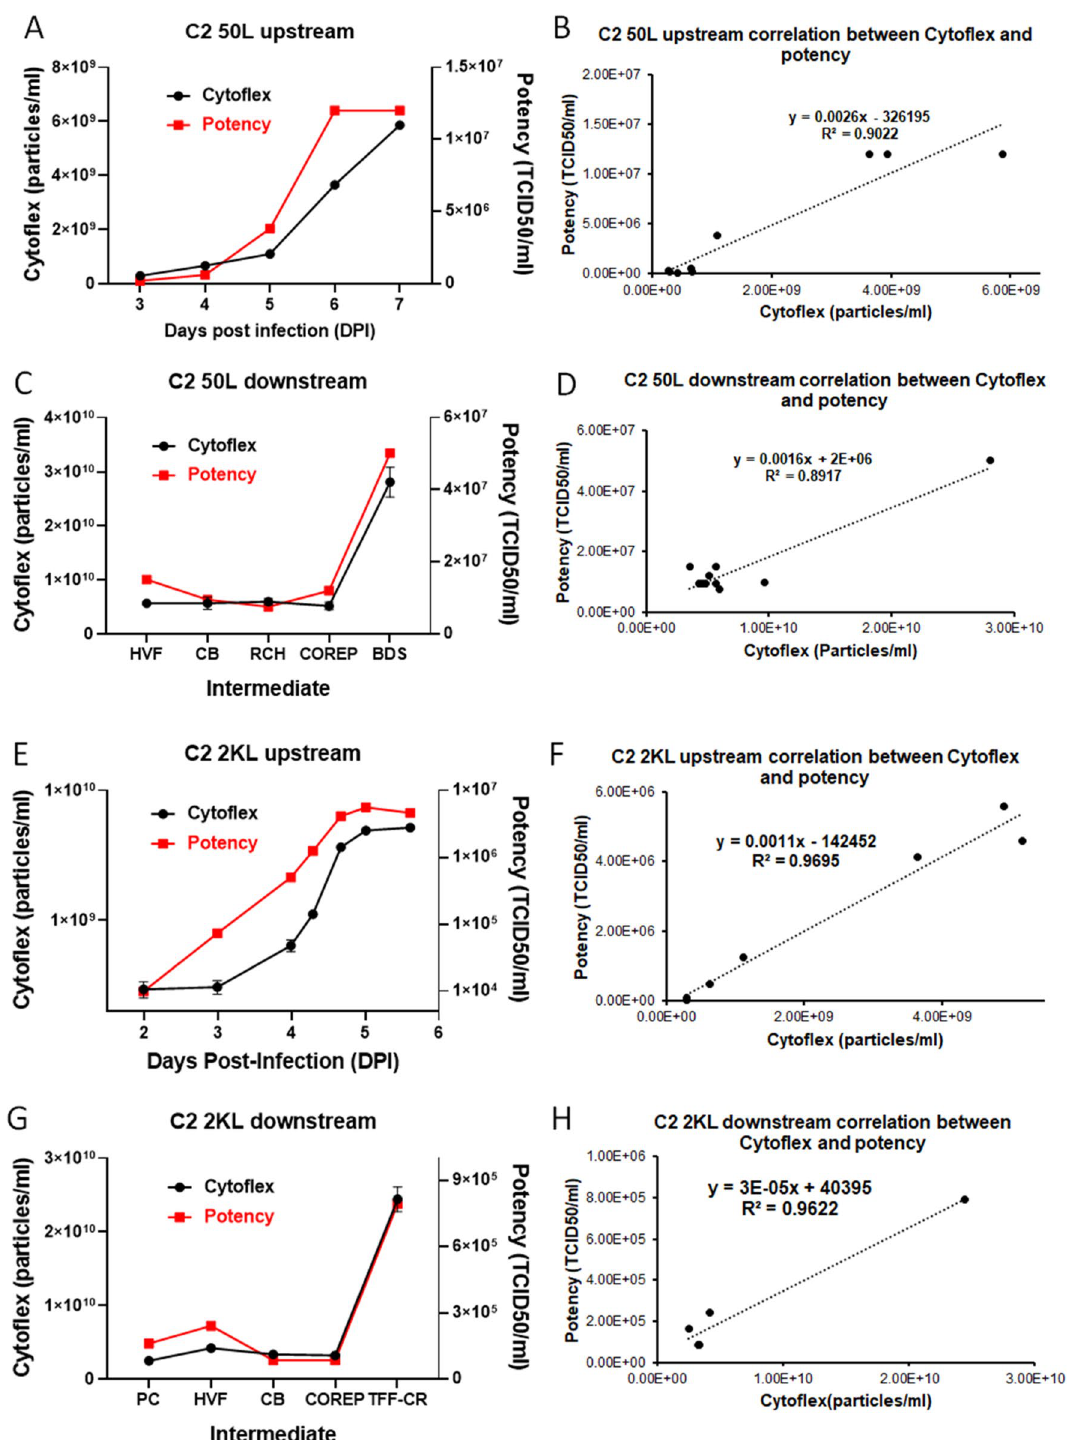
Figure 7. The production of C2 manufactured in 50L and 2000L bioreactors was monitored by CytoFLEX and showed strong correlation with potency. ( A ) Potency and total particle count of C2 50L bioreactor samples at different days post infection (DPI). ( B ) Correlation between total particle count measured by CytoFLEX and potency obtained from TCID50 assay for C2 50L bioreactor samples (R = 0.95, N = 9). ( C ) Potency and total particle count of C2 50L after each downstream process step for virus harvest, clarification, endonuclease reaction, purification, and concentration: production culture (PC), harvested viral fluid (HVF), clarified bulk (CB), capto core product (COREP), and tangential flow filtration concentrated retentate (TFF-CR). ( D ) Correlation between total particle count measured by CytoFLEX and potency obtained from TCID50 assay for C2 50L downstream intermediates (R = 0.94, N = 10). ( E ) Potency and total particle count of C2 2000L bioreactor samples at different days post infection (DPI). ( F ) Correlation between total particle count measured by CytoFLEX and potency obtained from TCID50 assay for C2 2000L bioreactor samples (R = 0.98, N = 7). ( G ) Potency and total particle count of C2 2000L intermediates during downstream purification. ( H ) Correlation between total particle count measured by CytoFLEX and potency obtained from TCID50 assay for C2 2000L downstream intermediates (R = 0.98, N =